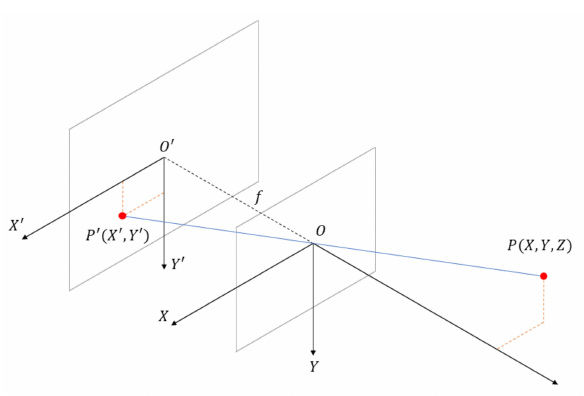
Figure 3. Schematic diagram of camera projection. P is the position of the spatial point, O is the optical center of the camera, O (cid:48) X (cid:48) Y (cid:48) is the camera imaging plane, and P (cid:48) is the projection of P on the imaging